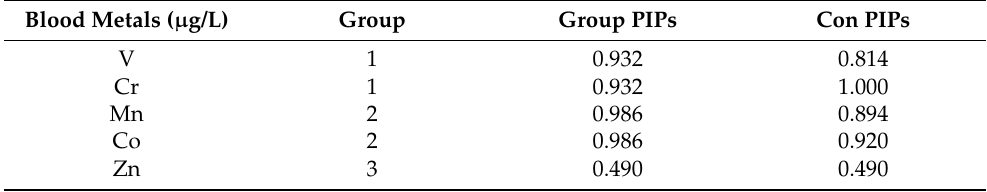
Table 3. PIPs for group and conditional inclusions for male hyperuricemia using BKMR model.